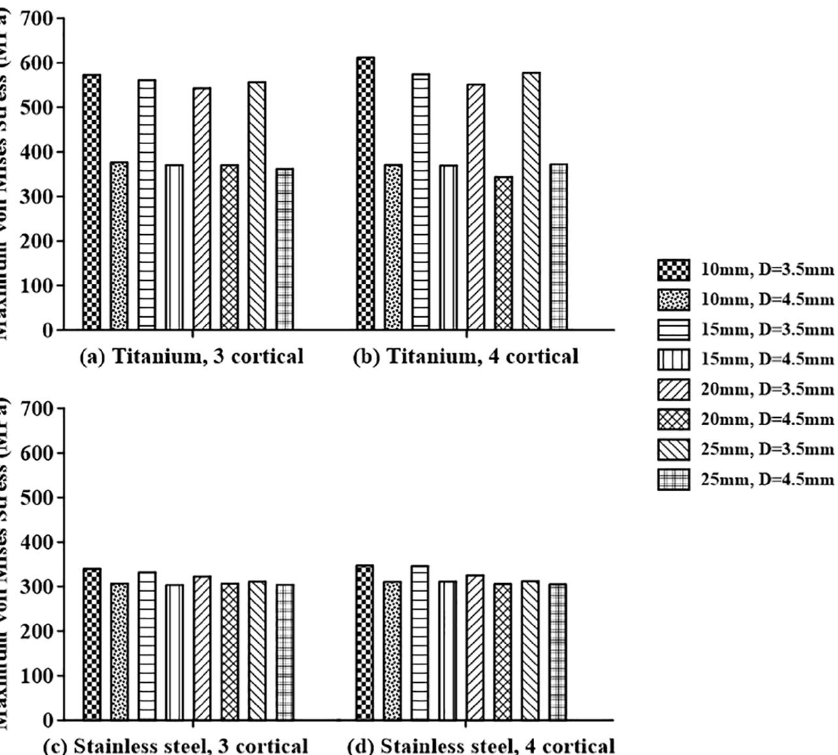
Figure 7. Analysis of the maximum von Mises stresses of the syndesmotic screw in terms of the diameter of the syndesmotic screw for: ( a ) titanium screw penetrating three cortical bones, ( b ) titanium screw penetrating four cortical bones, ( c ) stainless steel screw penetrating three cortical bones, and ( d ) stainless steel screw penetrating four cortical bones. Appl. Sci. 2020 , 3 , x FOR PEER REVIEW